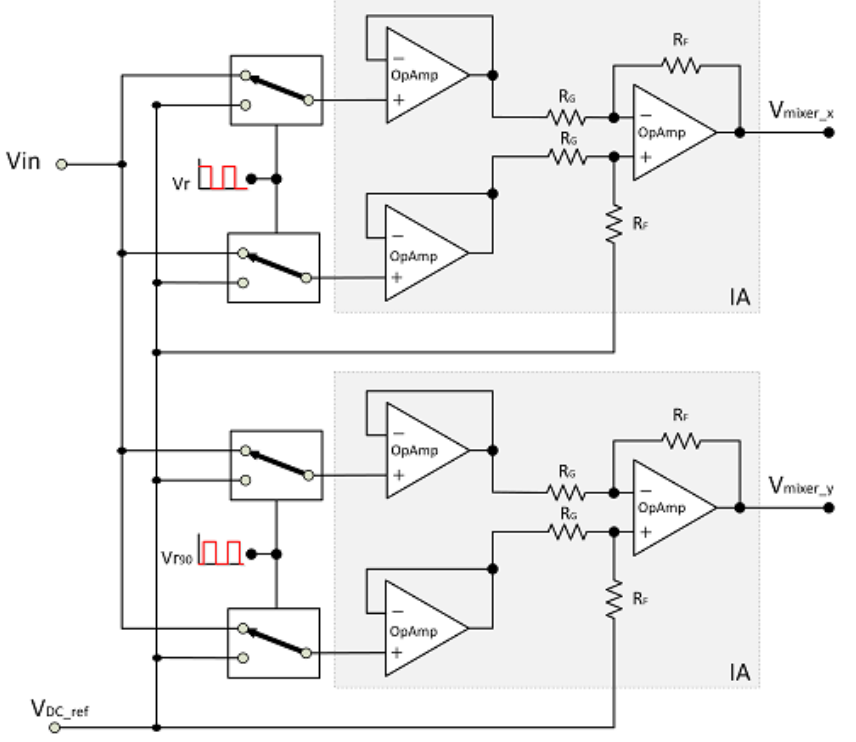
Figure 3. LIA scheme, detailing the instrumentation amplifier architecture: a precision differential architecture design with input